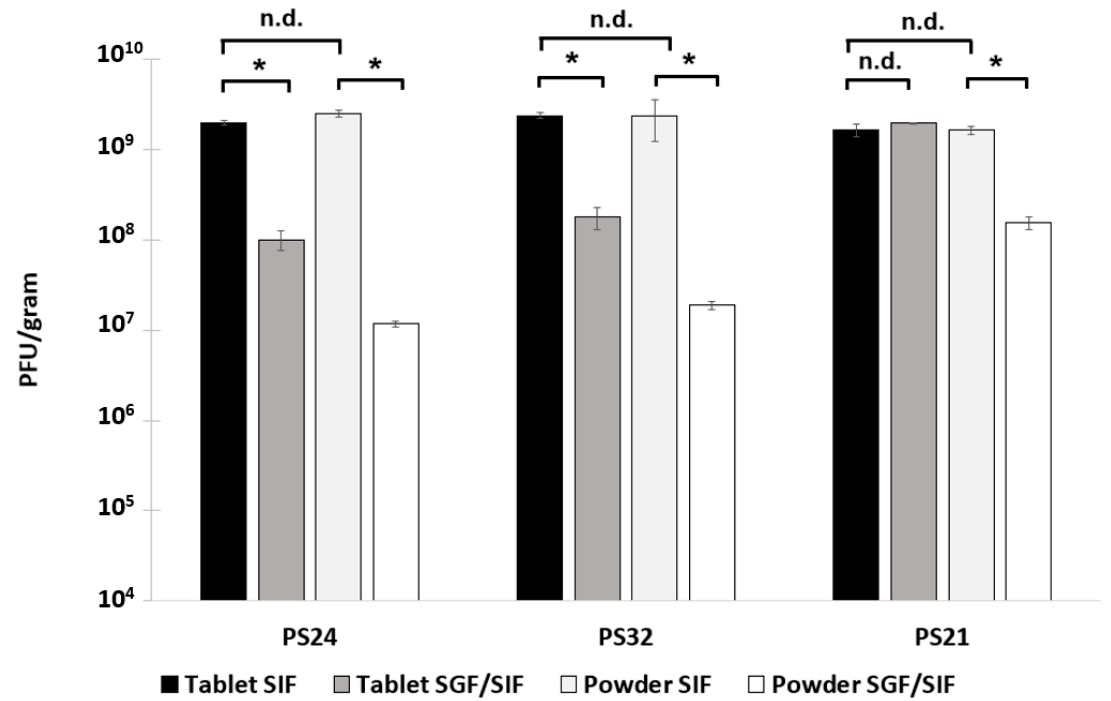
Figure 4. Encapsulated Felix O1 phages released in SIF from spray-dried powders and corresponding tablets using three different formulations. Samples labelled SIF were exposed to SIF only without acid exposure, whereas samples labelled SGF/SIF were exposed first to simulated gastric fluid (pH 2) for 2 h and were then centrifuged, before the supernatant was withdrawn and SIF was added to the sample. Phage titres were measured after 3 h of exposure to SIF for powders and 5 h of exposure to SIF for tablets to ensure complete dissolution of tablets. * Indicates significant difference in means ( p < 0.05) using a two-sample t -test; n.d. means no difference ( p > 0.05). Error bars represent one standard deviation; all measurements were done in triplicate ( n = 3).